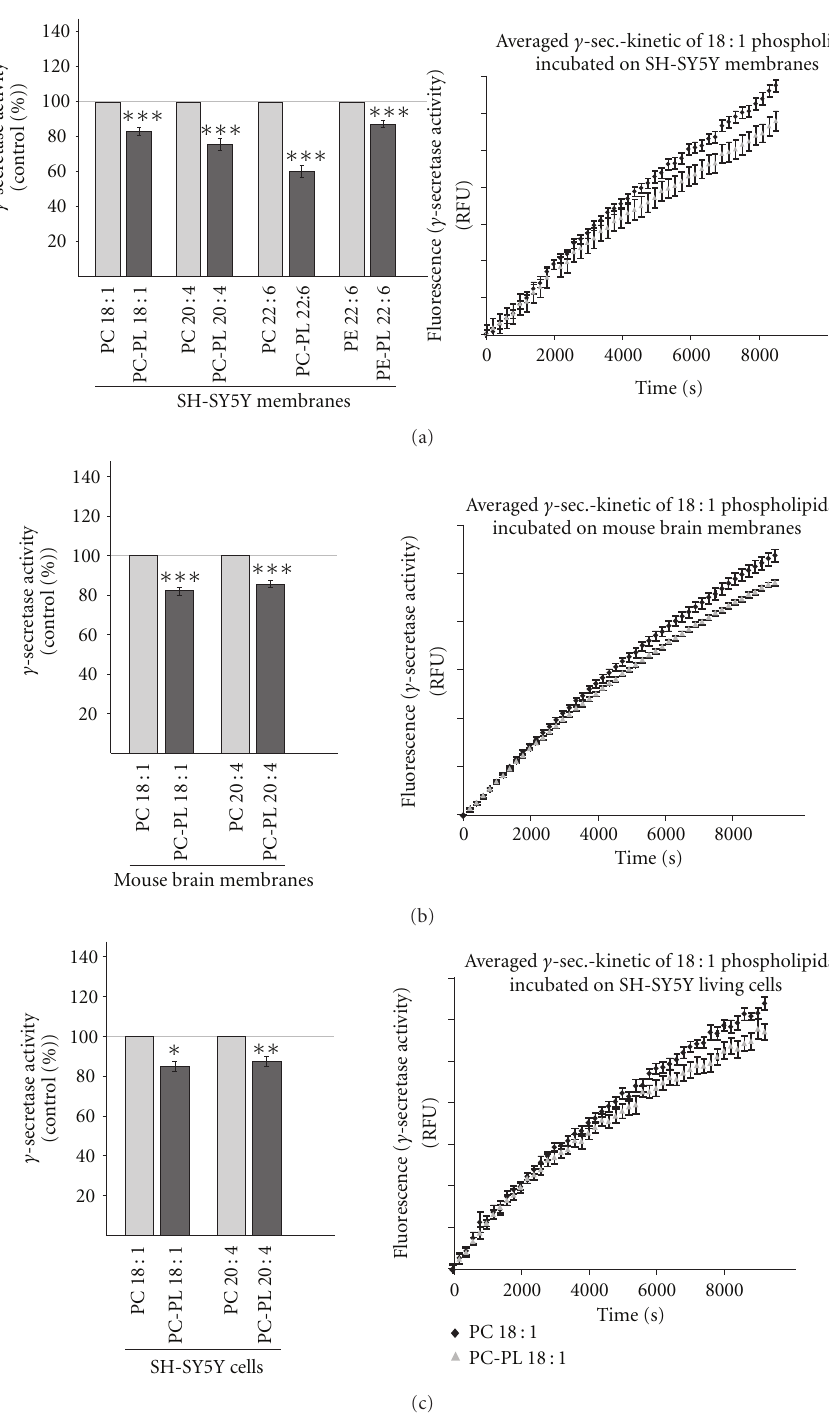
Figure 4: Determination of γ -secretase activity in the presence of PC-PL 18: 1, PC-PL 20: 4, PC-PL 22 :6, and PE-PL 22:6. (a) Influence on γ -secretase activity in purified membranes of human SH-SY5Y cells. Purified membranes of SH-SY5Y cell were incubated with PC-PL 18:1, 20 :4, 22: 6, or PE-PL 22:6 and the corresponding phospholipids (100 μ M), and γ -secretase activity was determined by a fluorometric assay. (b) Influence on γ -secretase activity ex vivo in purified membranes of mouse brains. Purified mouse brain membranes were incubated with PC-PL 18:1 and PC-PL 20:4 and the corresponding phospholipids (100 μ M), and γ -secretase activity was determined. (c) Cultured SH-SY5Y cells were incubated with PC-PL 18: 1 and PC-PL 20 :4 and the corresponding phospholipids PC 18:1 and PC 20: 4 for 24 hours in a final concentration of 100 μ M. Membranes of incubated SH-SY5Y cells were prepared and γ -secretase activity was determined with a fluorometric assay. (a, b, c) Representative kinetics are shown for PC-PL 18:1 and PC 18: 1. All quantified data represent an average of at least three independent experiments. Illustration and statistical significance are as described for Figure